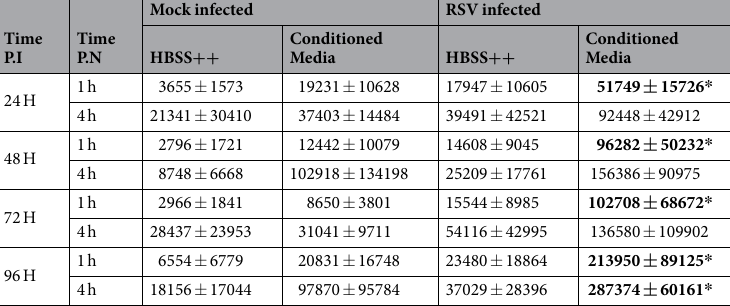
Table 1. Number of migrated neutrophils. P.I indicates post-infection. P.N. indicates post-neutrophil migration. Mean and SD shown (n = 4), boldface and * indicates significant increase in migrated neutrophils compared to respective Mock infected